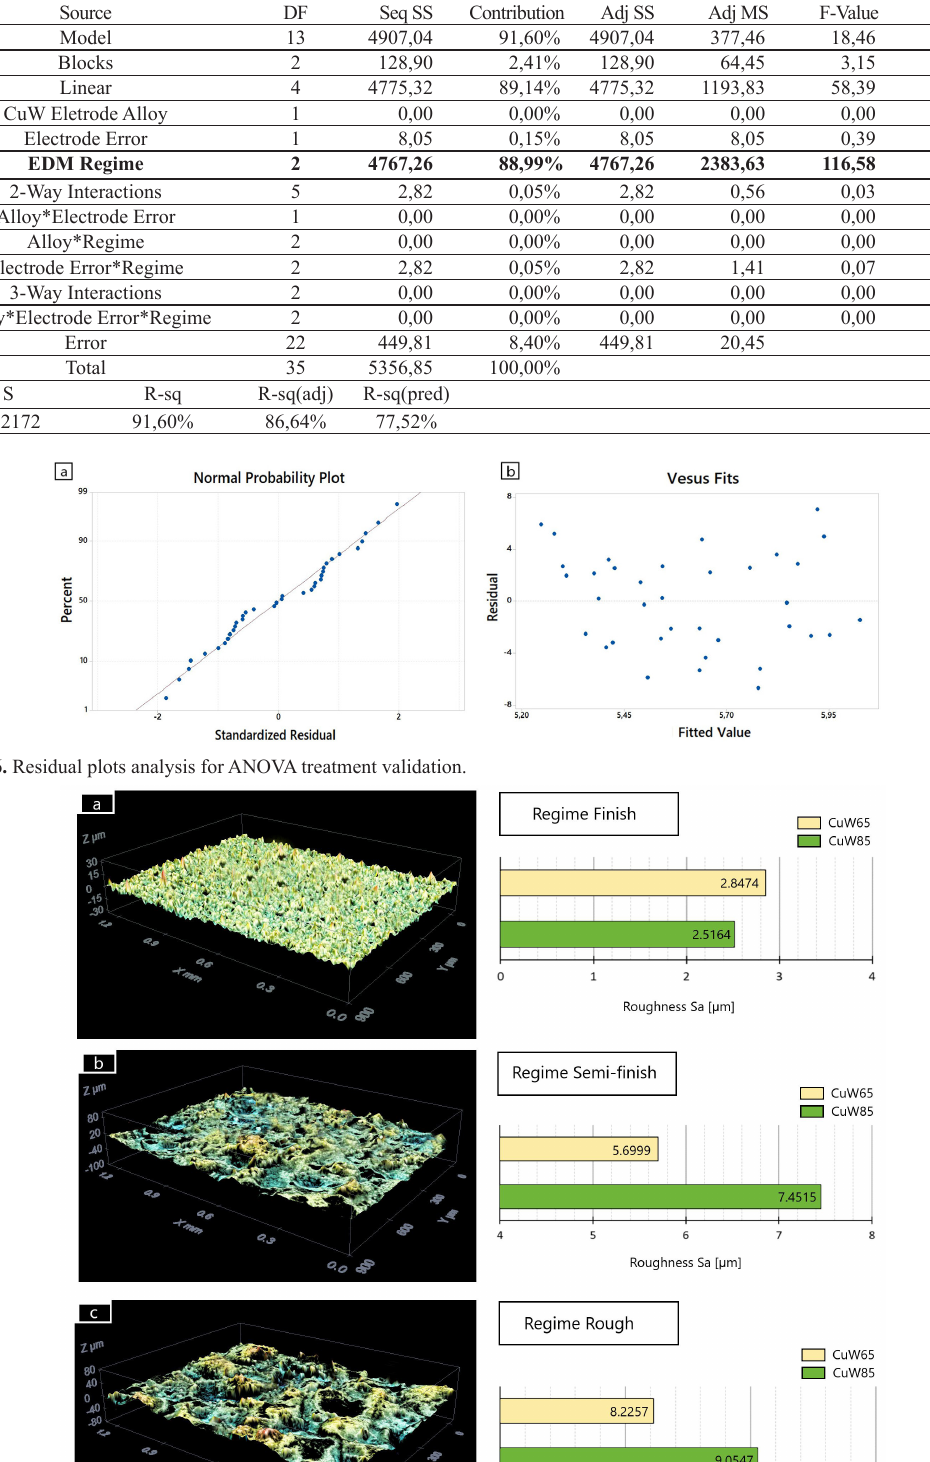
= 37 A, t = 180 µs) regimes using the two CuW electrodes grades (CuW65% and e e